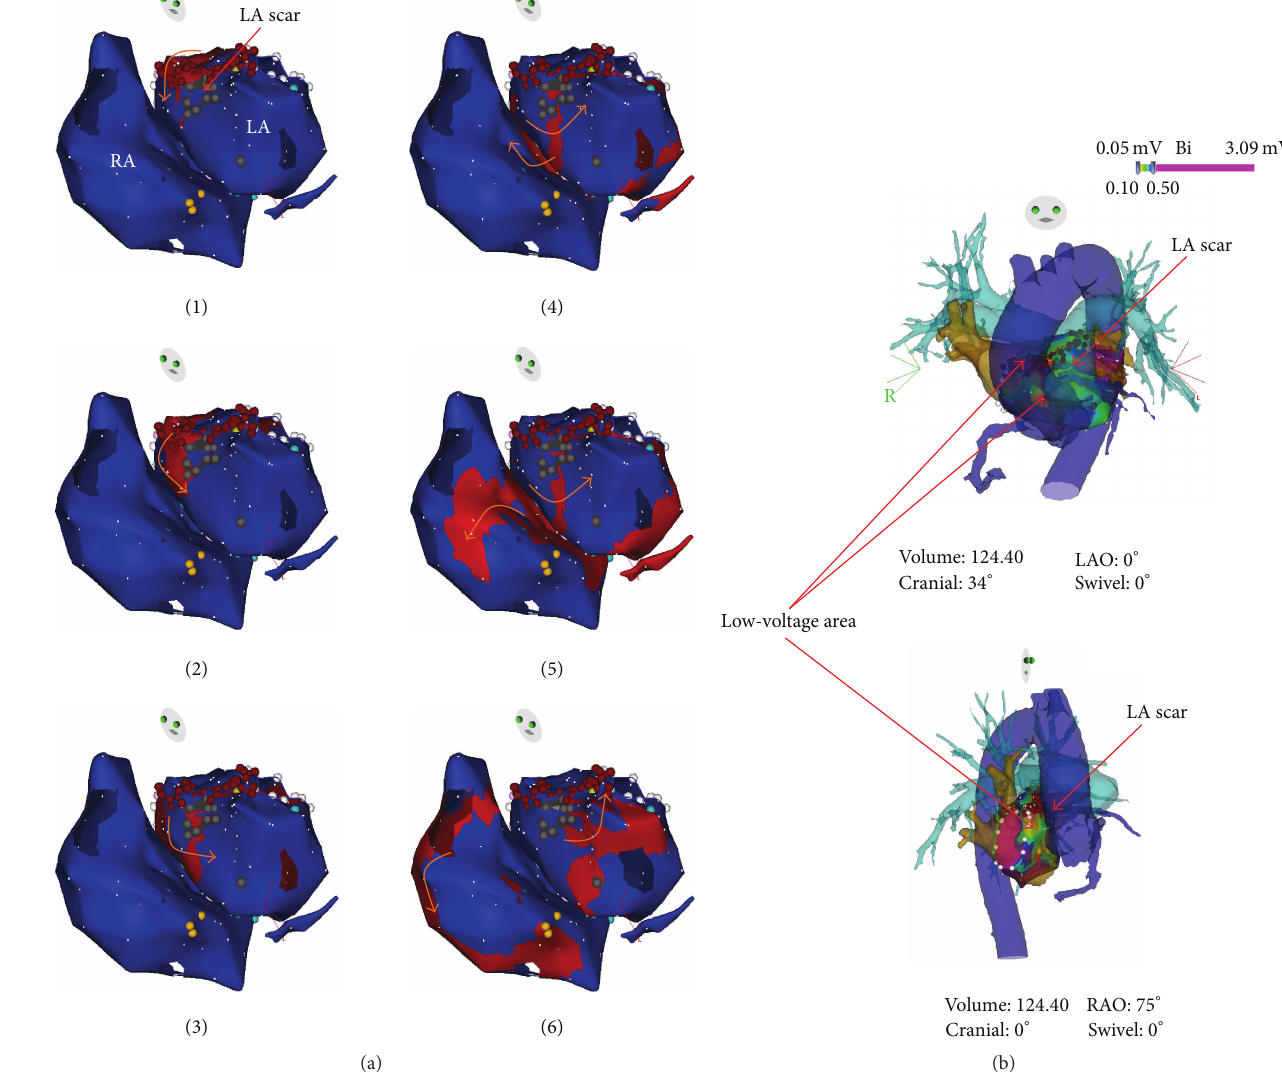
Figure 4: (a) The propagation map of AT with the LA, right atrium (RA), and CS. Arabic numbers indicate the time course of AT. The wavefront conducts around the LA scar with no excitation of the RA (images 1–3). The mid to inferior part of the RA began to activate (image 4). The RA wavefront went up to the RA septum and turned around the TA in a counterclockwise manner (images 5 and 6). The orange arrowhead indicates the AT wavefront. (b) The anatomical relationship between the LA low-voltage area and the ascending aorta, as well as between the LA scar and the pulmonary artery presented with the 3D electroanatomical map of the LA merged with computed tomography. As indicated by the red line, the LA scar was represented by grey area and the low-voltage areas were represented by red, yellow, and green